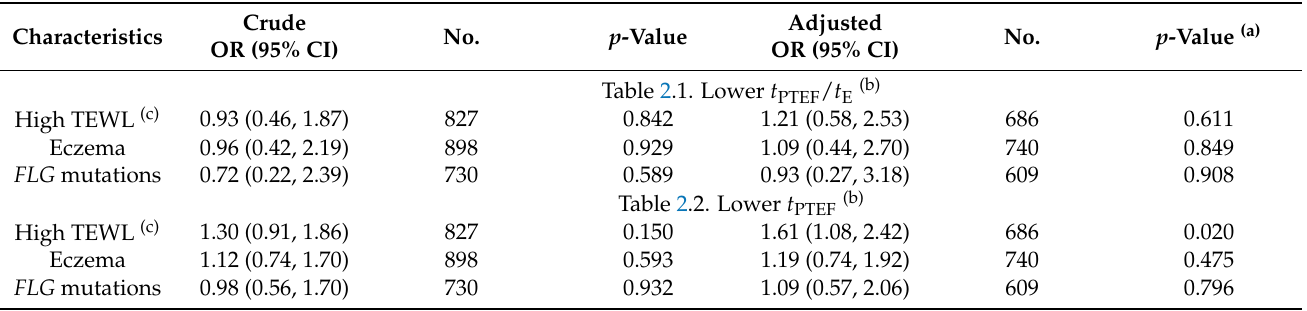
Table 2. 1,2. Logistic regression models for high TEWL, eczema, or FLG mutations and lower